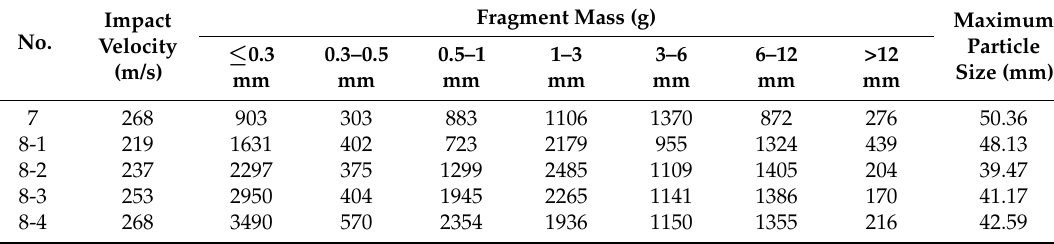
Table 3. Sieving results of the coal fragments under water jet impact in different WJD